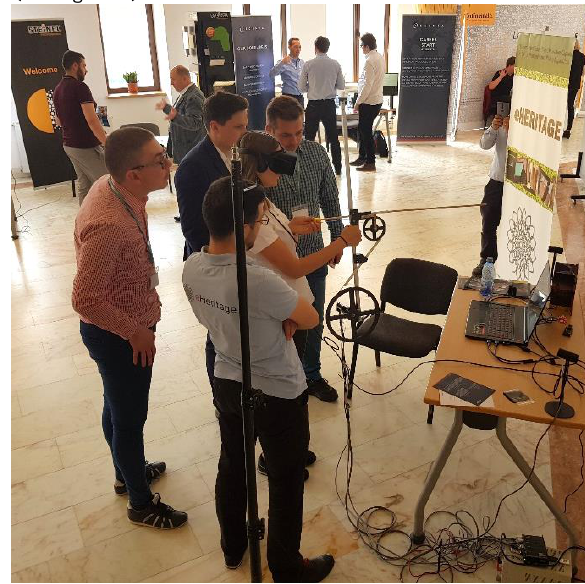
Figure 5. Students trying the haptic bow at GFCO